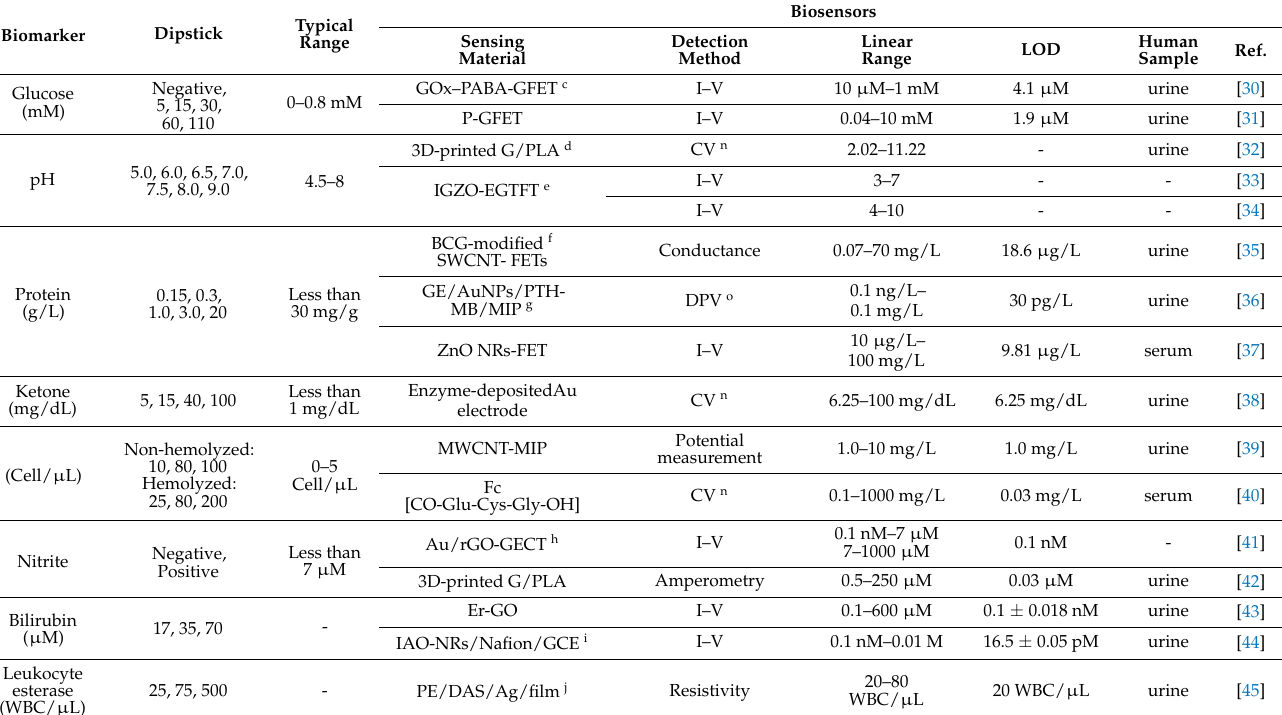
Table 1. Summary of biosensors developed to identify urine-based biomarkers that are typically detected by dipstick